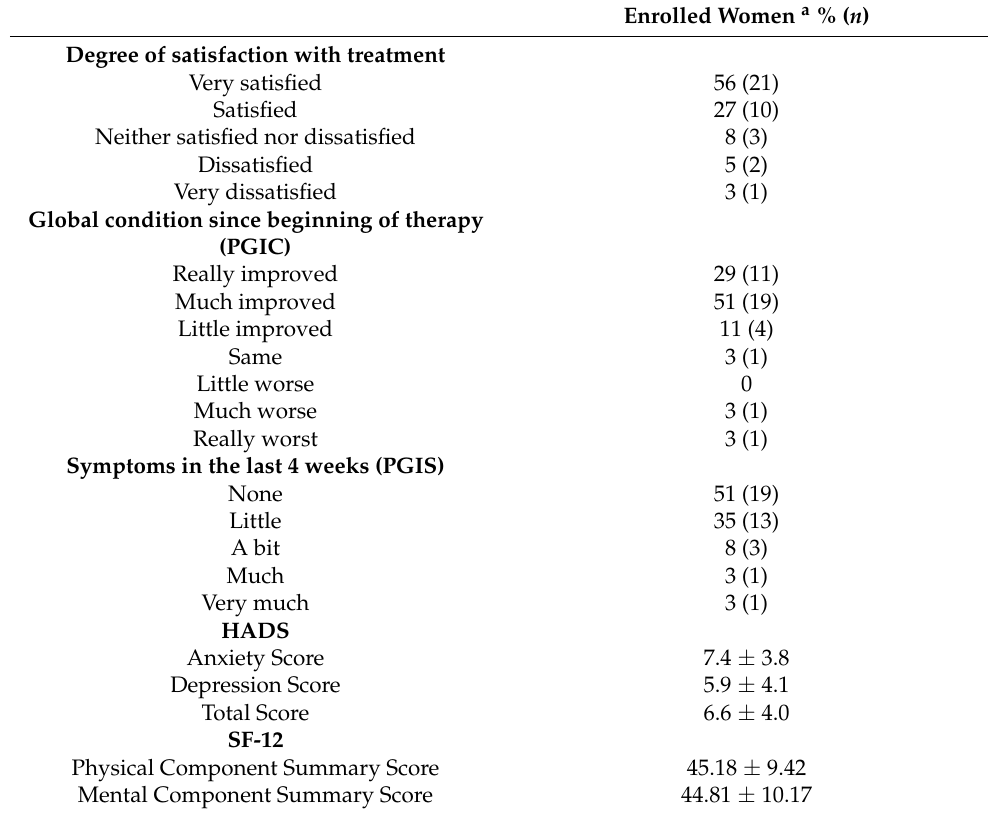
Table 3. Follow up of 37 women with umbilical endometriosis. Degree of satisfaction with treatment and results of the standardized questionnaires on the women’s health